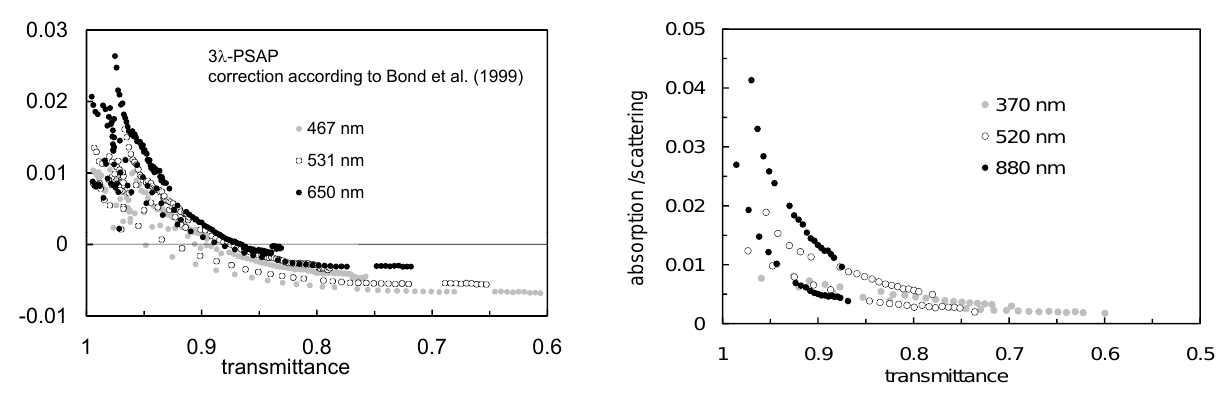
Fig. 11. Sensitivity to particle scattering as a function of filter trans- mittance for the 7 λ -Aethalometer. Shown are the ratios of absorp- tion coefficients divided by scattering coefficients for three wave- lengths. Absorption coefficients were corrected using Weingartner et al.